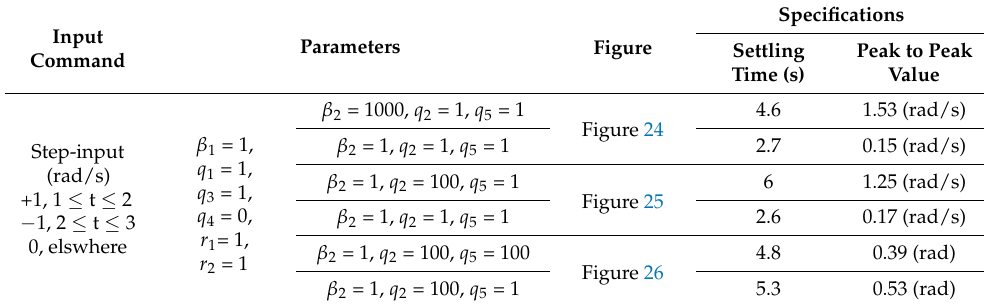
Table 2. The quantitative comparison of angular